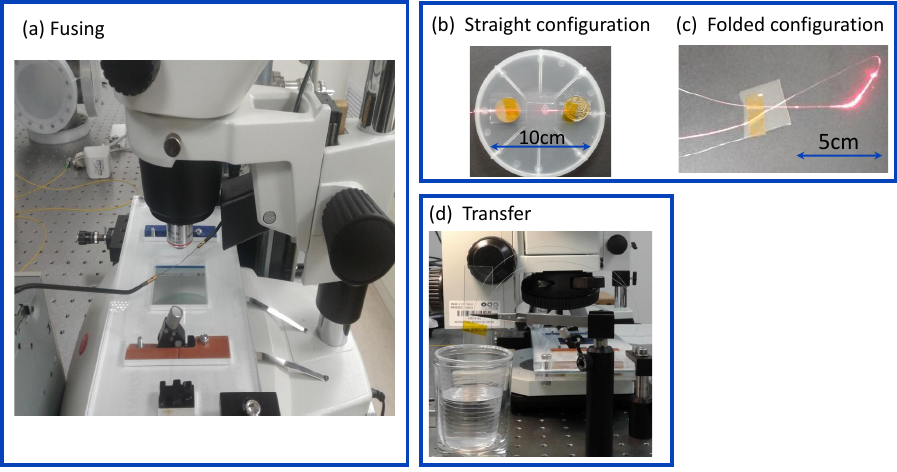
Figure 2. Stages of OMF preparation. ( a ) Fusing; ( b ) Straight configuration following positioning; ( c ) Folded configuration following positioning; ( d ) Transfer to measurement